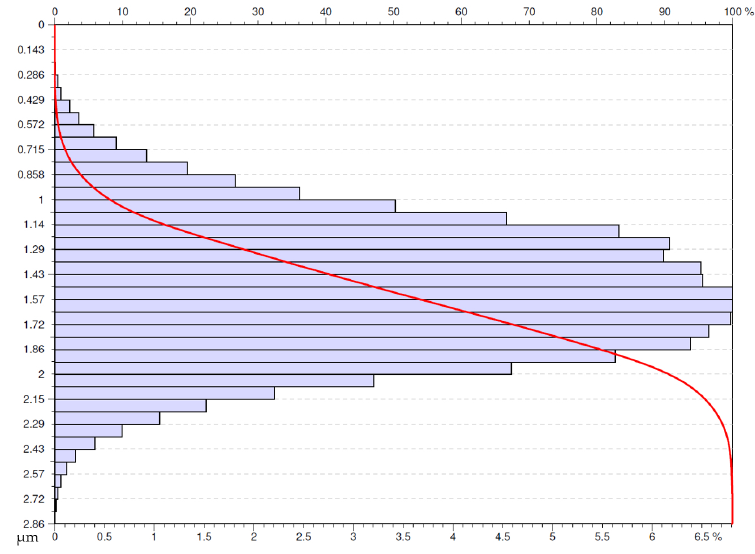
Figure 19. Abbott-Firestone curve after wet turning by Wiper insert with feed f = 0.05 mm/rev. A similar shape of the Abbot-Firestone curve was obtained for the surface after dry turning with the Wiper insert at the feed rate, f = 0.05 mm/rev (Figure 20). The distribution higher values of the distribution.